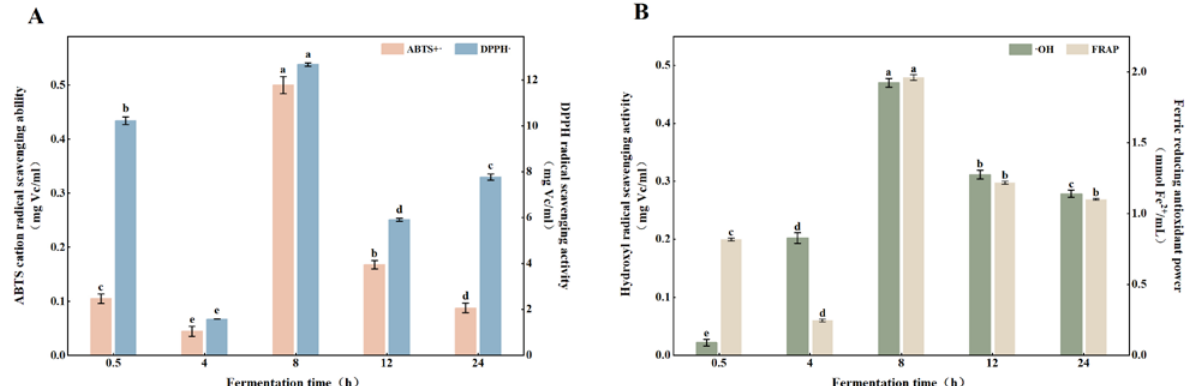
Figure 4. In vitro antioxidant activity of fermentation broth during in vitro fermentation. ( A ) ABTS and DPPH radical scavenging activity; ( B ) Hydroxyl radical scavenging activity and ferric reducing antioxidant power. Means with different letters in figures were significantly different at p < 0.05.